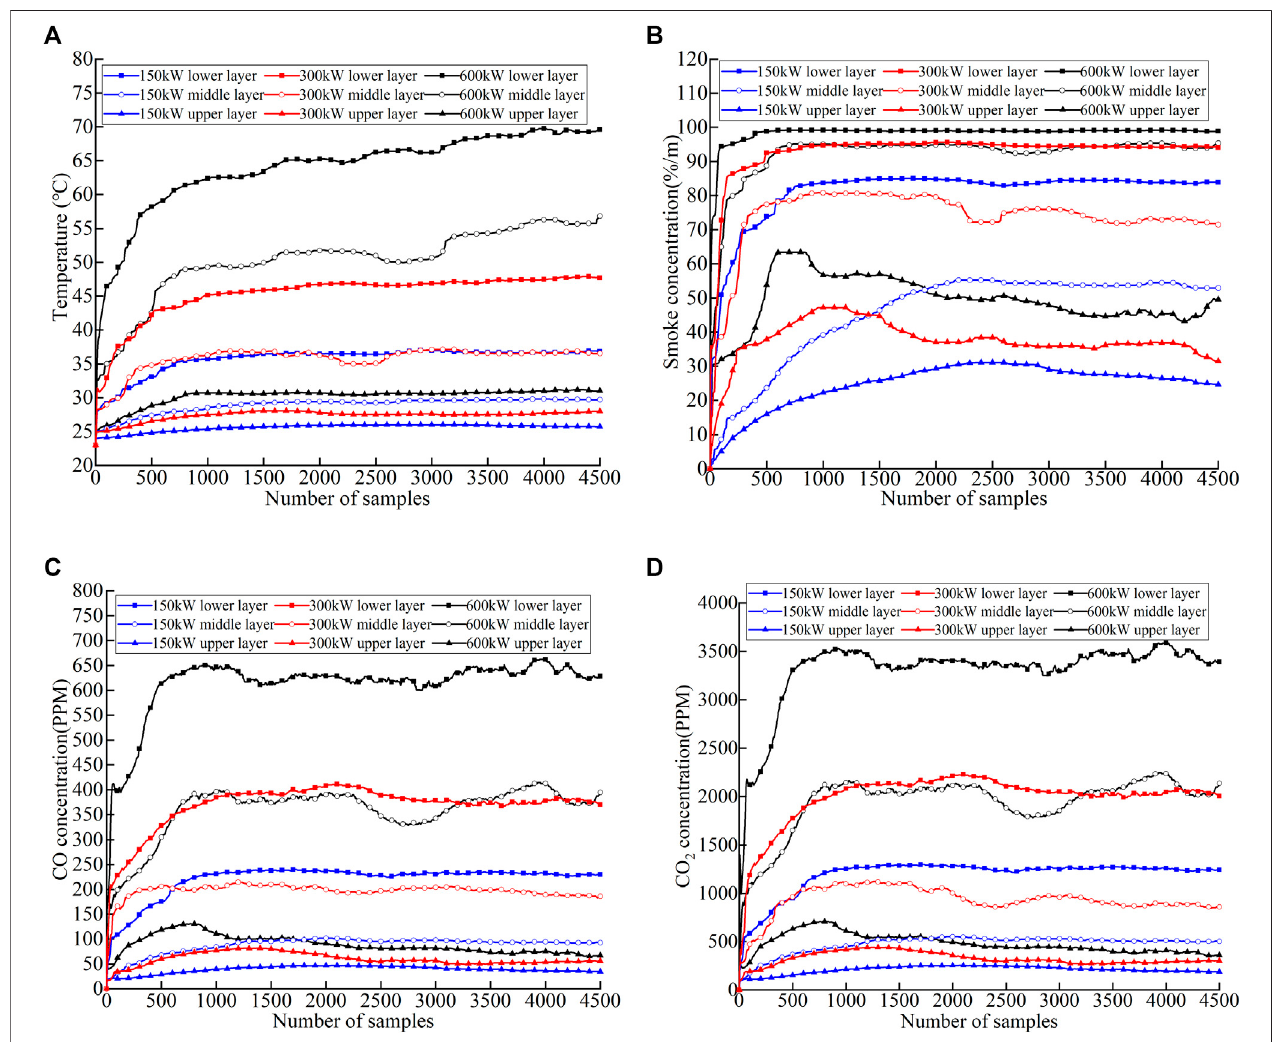
FIGURE 8 | The variation and comparison of sampling parameters. (A) Temperature, (B) smoke concentration, (C) CO, (D) CO 2 .